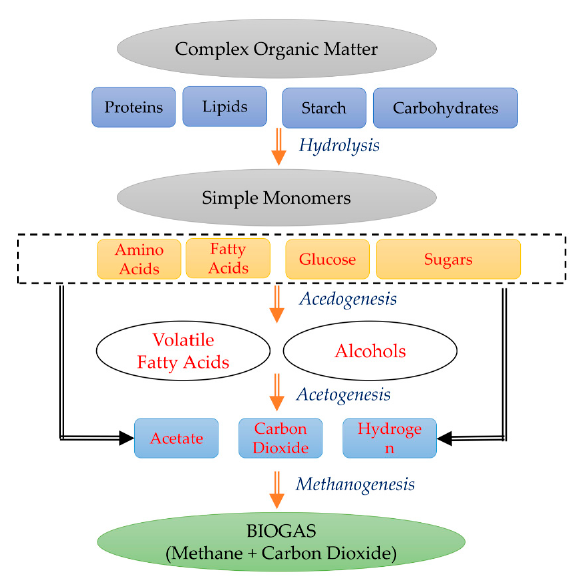
Figure 2. Steps in the Anaerobic Digestion Process.